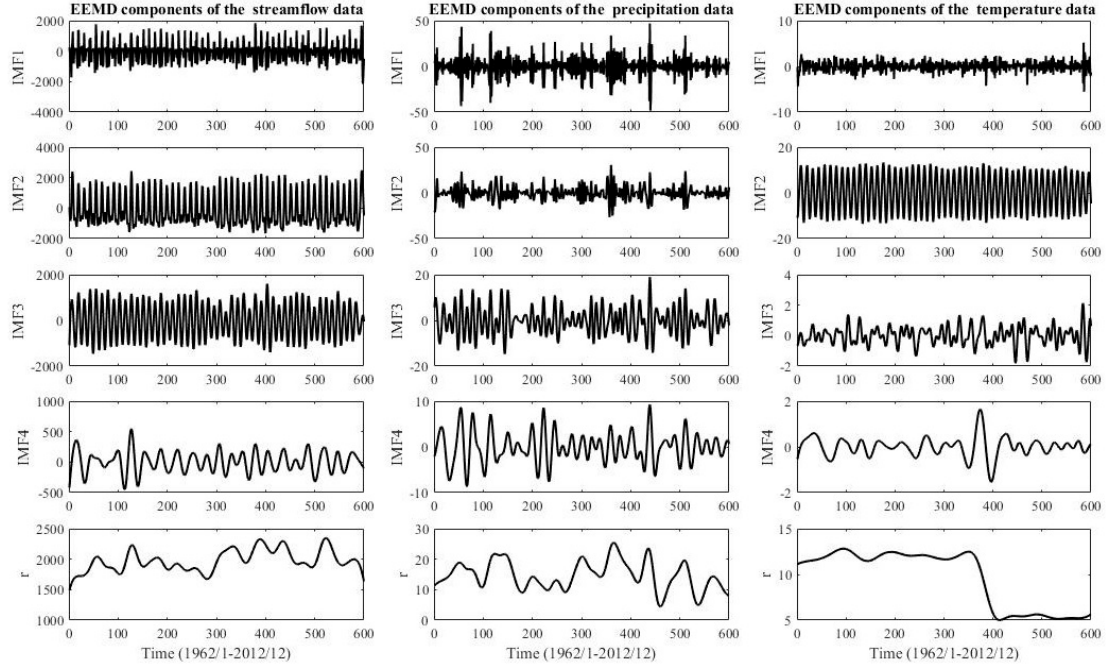
Figure 7. Zone One: streamflow, precipitation, and temperature data are decomposed by EEMD.